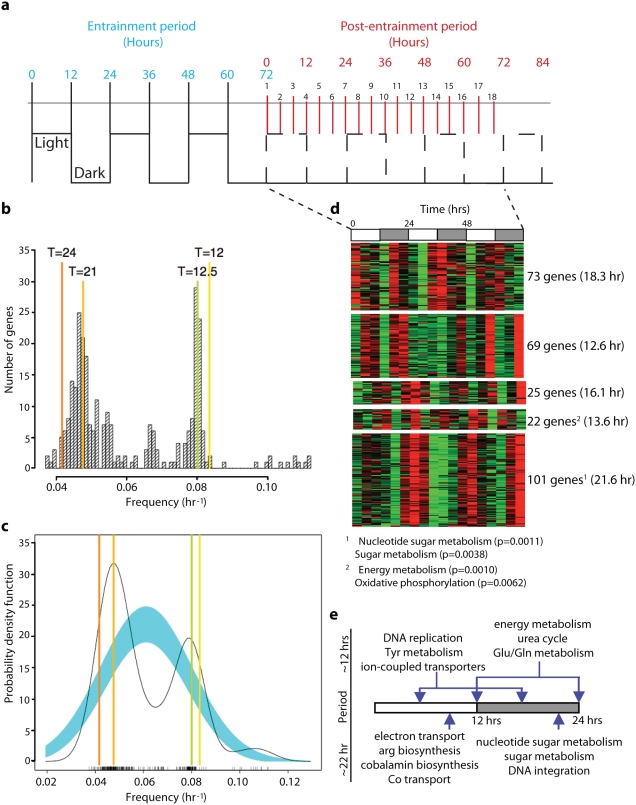
Discovery of diurnally entrained periodic gene expression in H. salinarum NRC-1.a, H. salinarum NRC-1 cells were entrained with 3 days of 12∶12 LD and subsequently released into constant darkness. Total RNA was prepared from samples collected immediately post-entrainment (t = 0 hrs), every four hours until t = 60 hours. Two additional samples were collected at t = 64.5 hrs and t = 68.5 hrs. Culture conditions during sampling were frequently monitored and controlled (Supplementary Table S1). b, Frequency histogram of genes detected with periodic transcriptional changes (binned at intervals of 0.001 hr−1, p<0.2) using Lomb-Scargle analysis. c, Spectral density (black line) of the histogram in (a) shows two dominant frequencies of ∼12.5 and ∼21 hours; the blue swath shows data distribution of normally distributed gene expression changes. d, Five k-means clusters of periodic transcriptional changes of the 290 genes (from Experiment A) in (a, b) are visualized as a heatmap [average period is shown in parentheses and overrepresented GO or KEGG physiological functions (p<0.01) are also indicated]. The phasing of the diurnal L∶D cycle is indicated at the top of the heatmap with alternating white and shaded rectangles, respectively. e, Phase alignment of periodic gene expression changes shows co-induction of related cellular functions according to the diurnal cycle. DNA replication, tyrosine metabolism and ion-coupled transporters were upregulated during the middle of the light and dark phase with a period of 13.6 hours. Transcription of genes encoding components of NADH dehydrogenase (ndhG3 and ndhG4), cytochrome oxidase (coxB), the urea cycle and glutamine-glutamate metabolism peaked at the transitions from one phase to the next. Finally, nucleotide sugar metabolism, general sugar metabolism, and DNA integration were maximally induced during the latter half of the dark phase.